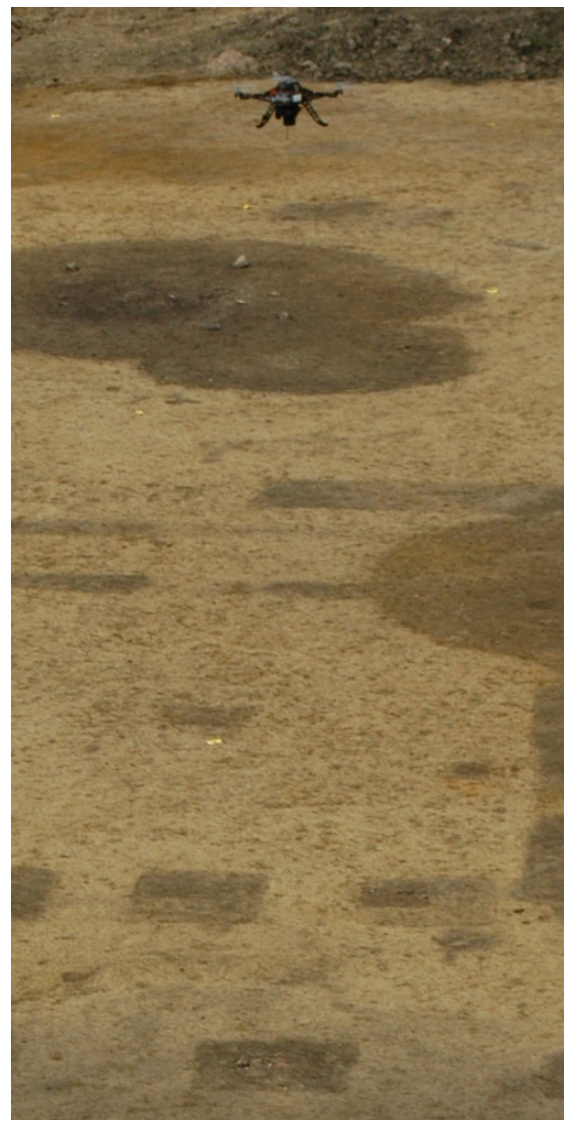
Figure 2: The quadrocopter flying in Neuhofen,